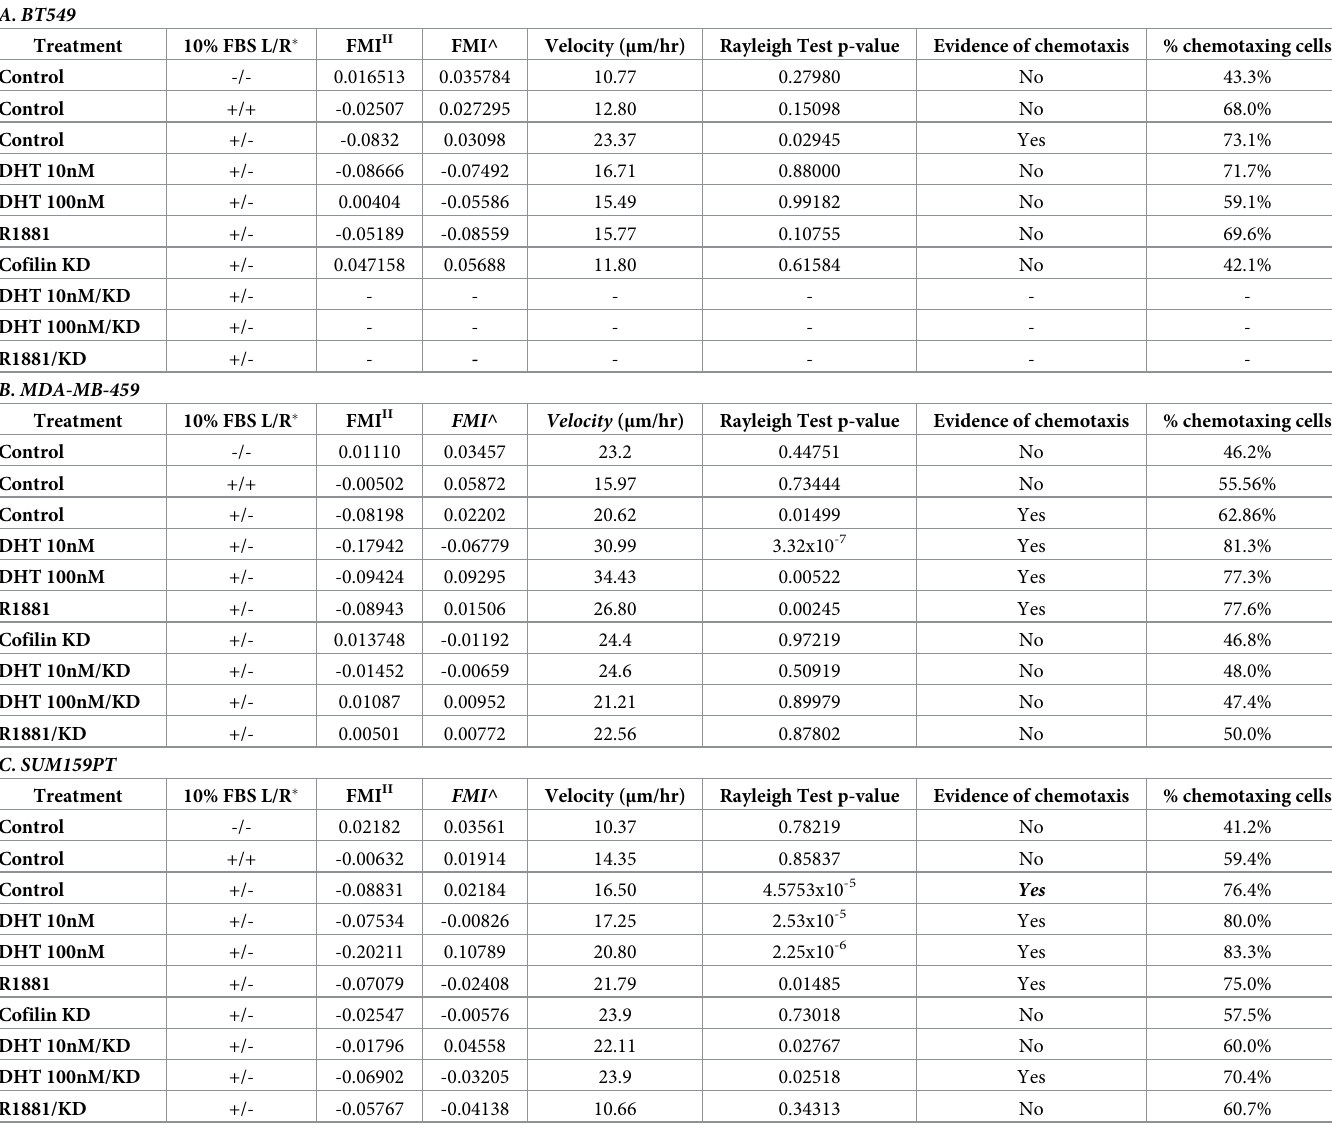
Table 1. Cell migration parameters as measured by μ -slide chemotaxis assay in control and treated TNBC cell. A .